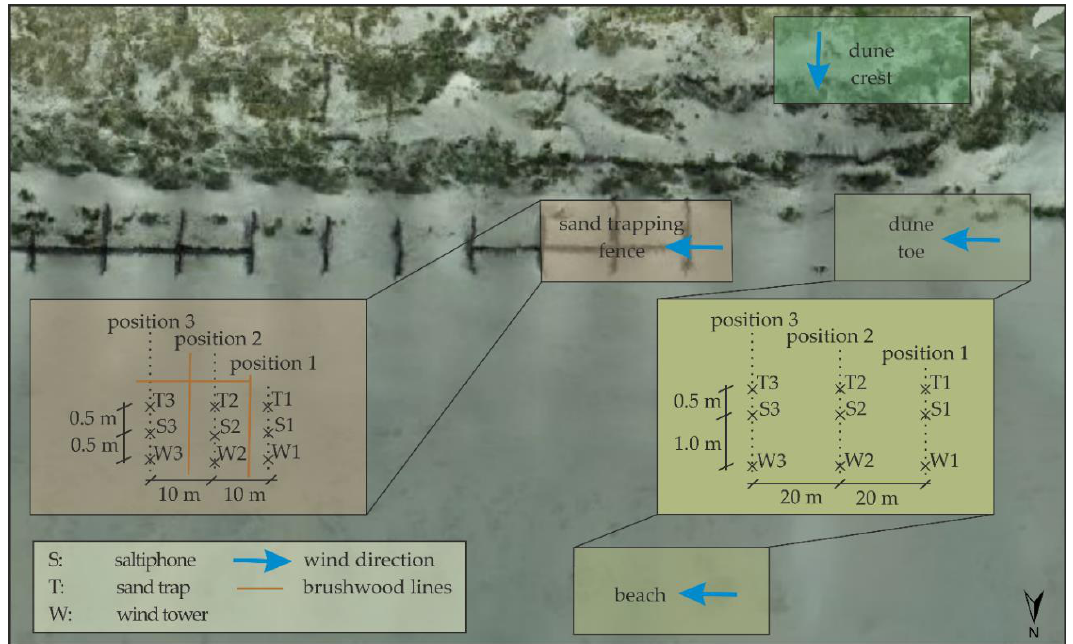
Figure 6. Aerial photograph for the measurement locations: beach, dune toe, dune crest (no sediment transport), and sand trapping fence with the arrangement of the vertical mesh sand traps, the saltiphones, and the wind towers. Blue arrows indicate the respective wind direction during measurements at each measurement location.